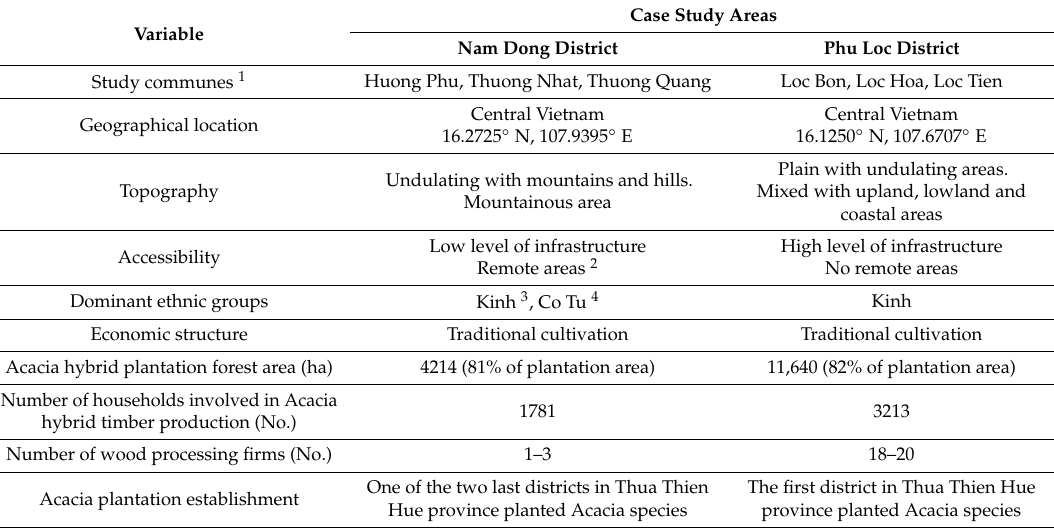
Figure 1. Location of the study areas. Source: Google Maps [41] and OCHA [42]. Table 1. Main characteristics of study areas.